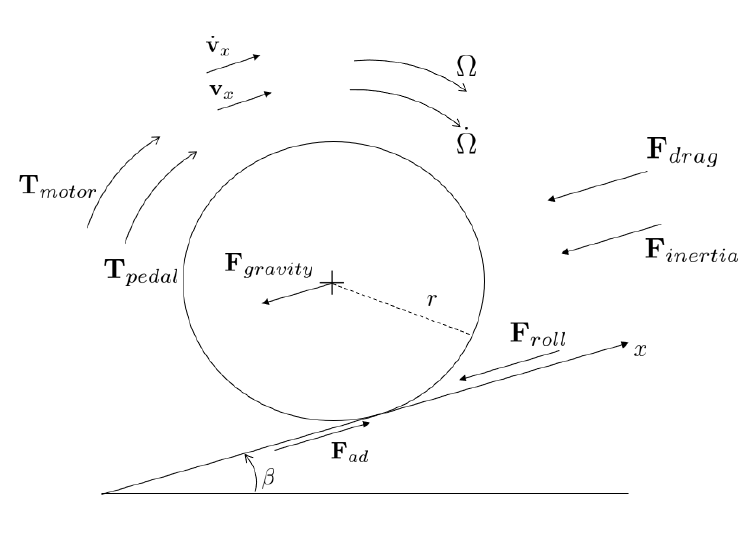
Figure 2. Back wheel longitudinal